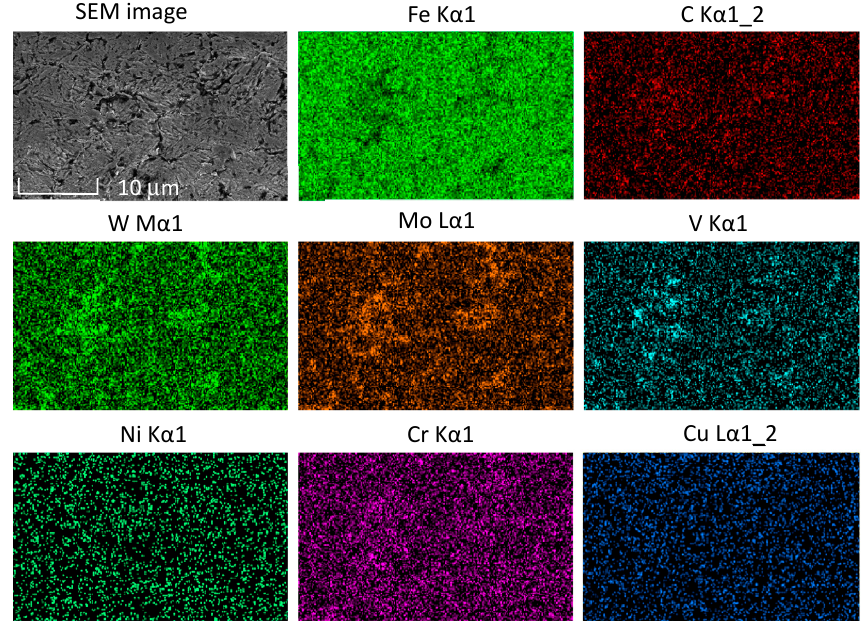
Figure 9. EDS mapping analysis results of coating.